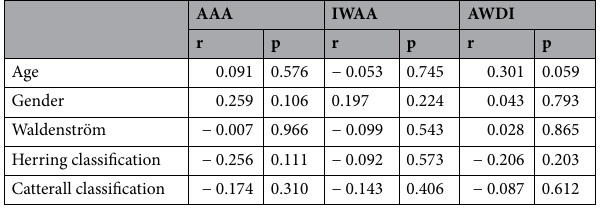
Table 4. One-way correlation analysis.